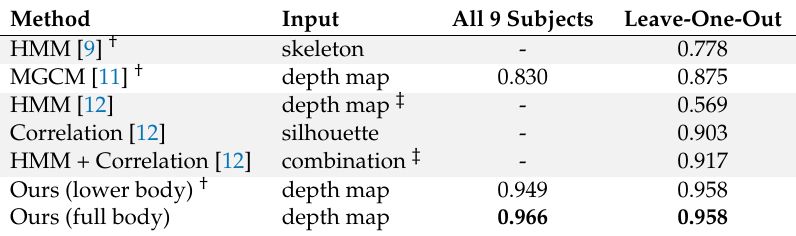
Table 3. The AUCs of related studies that employ different input data types. The notations † and ‡ indicate the consideration of only lower body and the use of data augmentation, respectively. The best results are highlighted in